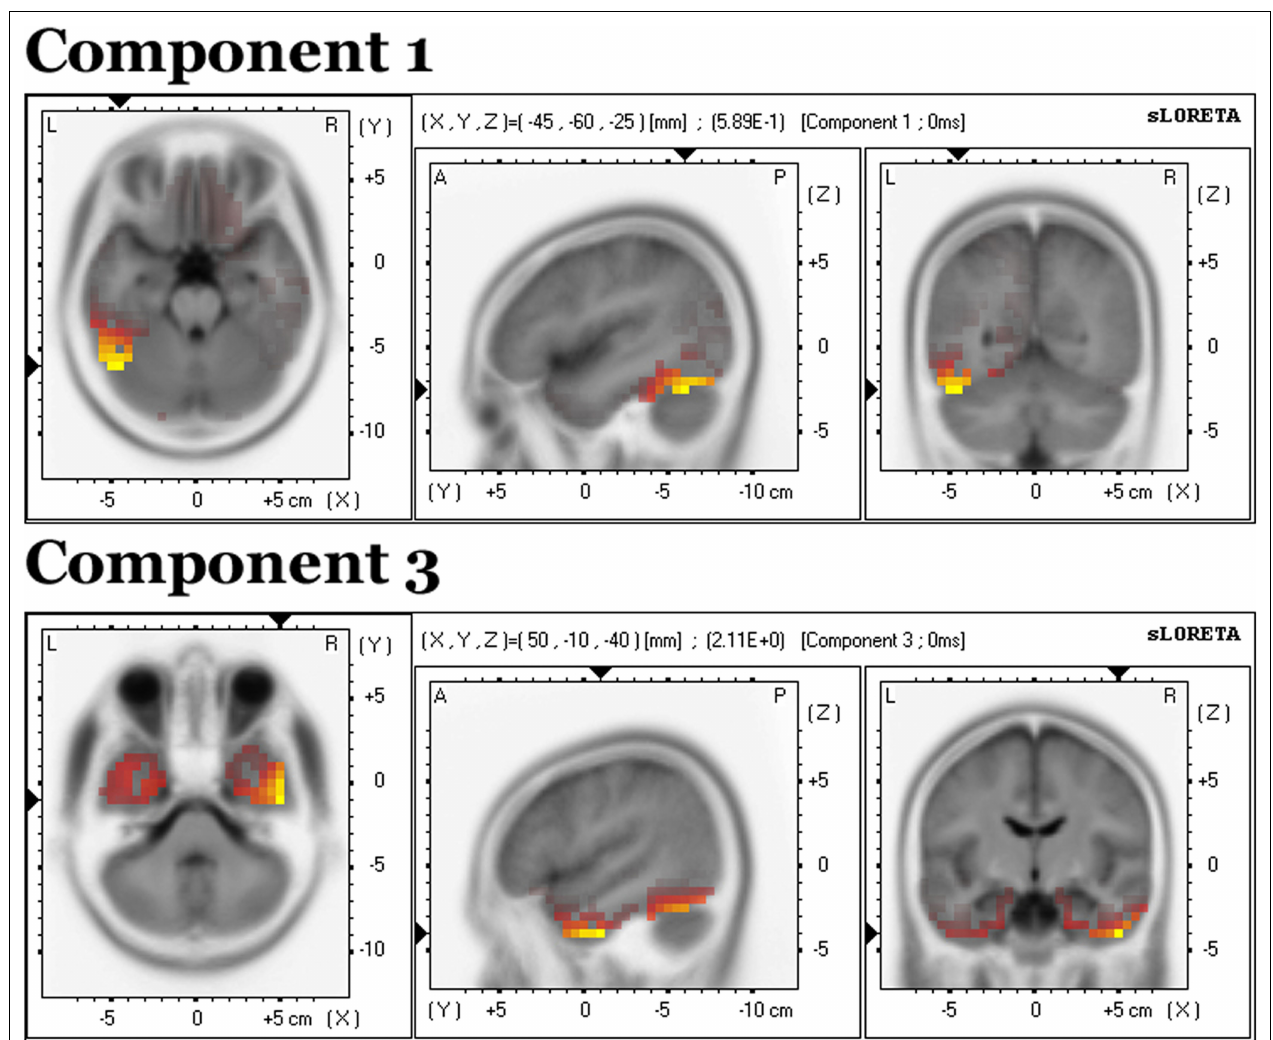
FIGURE 9 | Source localization from sLORETA for components 1 (top) and 3 (bottom). The solution is displayed on an MNI152 T2-weighted